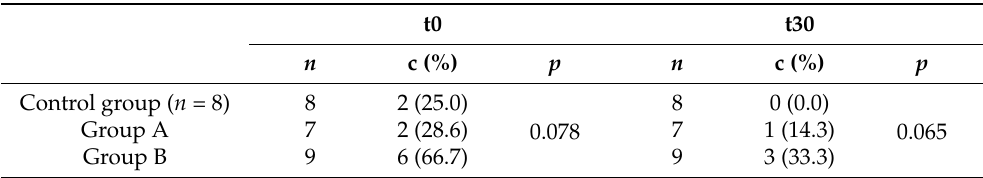
Table 3. Irregularly active and sedentary adult women according to time after cryolipolysis on one (group A) or multiple areas of the body (group B).